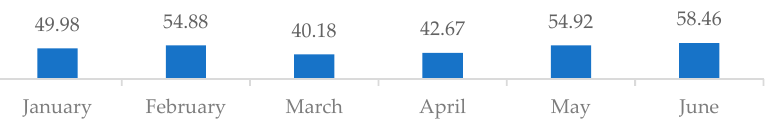
Figure 11. Average monthly electricity price (€/MWh) in the wholesale market in the Iberian Peninsula (OMIE) during the 6-month trial period (i.e., January–June 2018). Source: Adapted from OMIE [29].